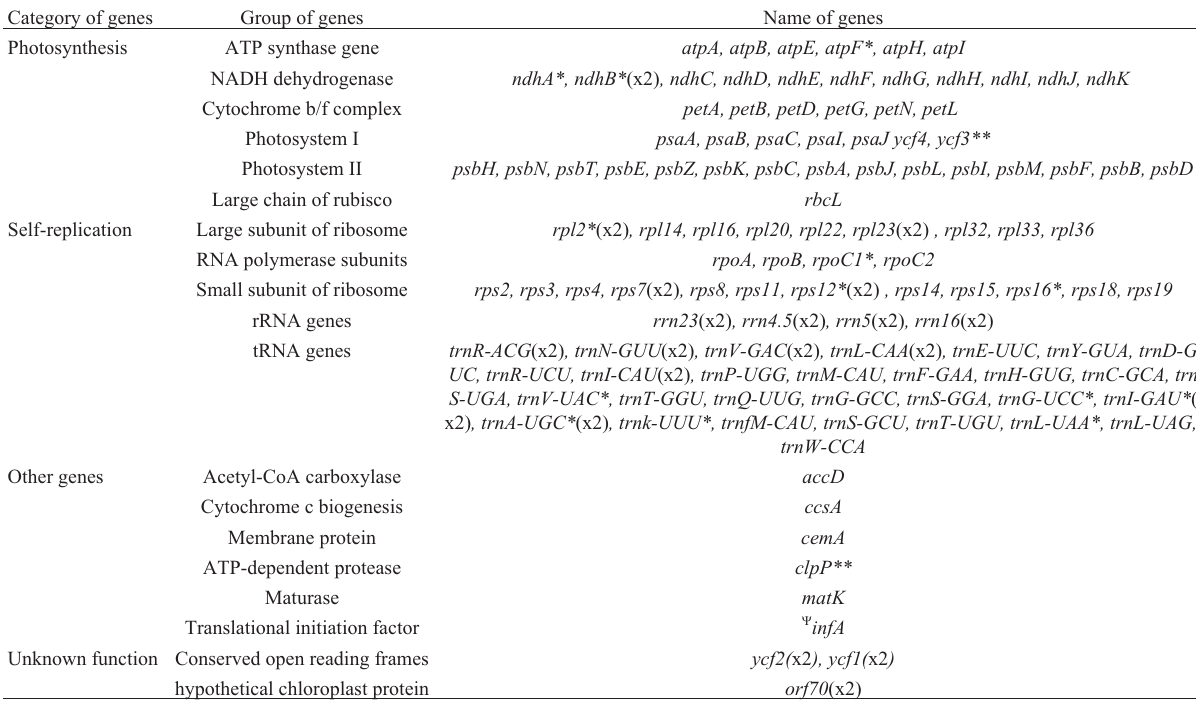
Table 1 - Gene content in the chloroplast genome of of Gynostemma yixingense. Category of genes